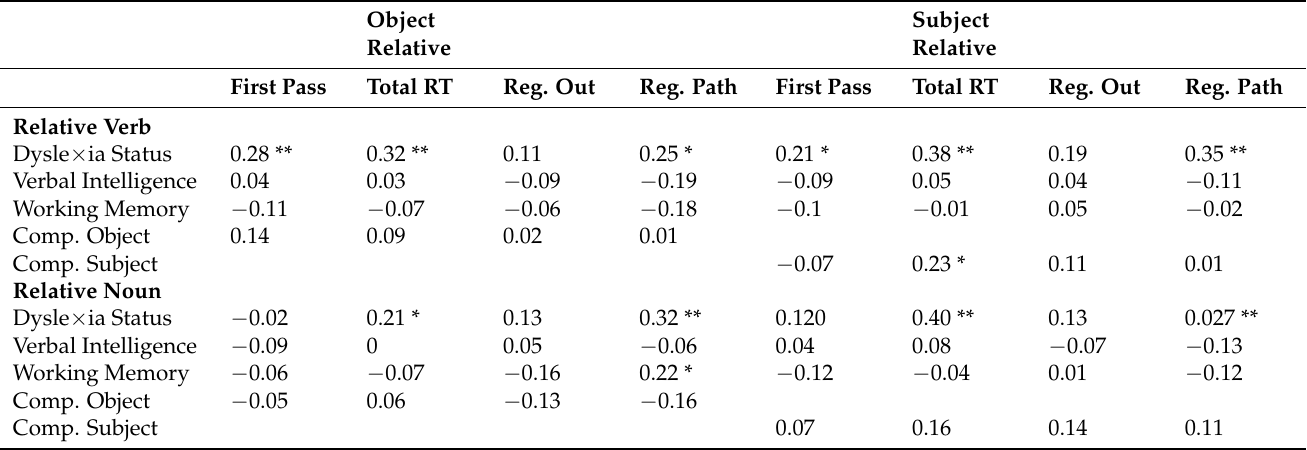
Table 8. Bivariate correlations between individual differences variables, comprehension and eye movement